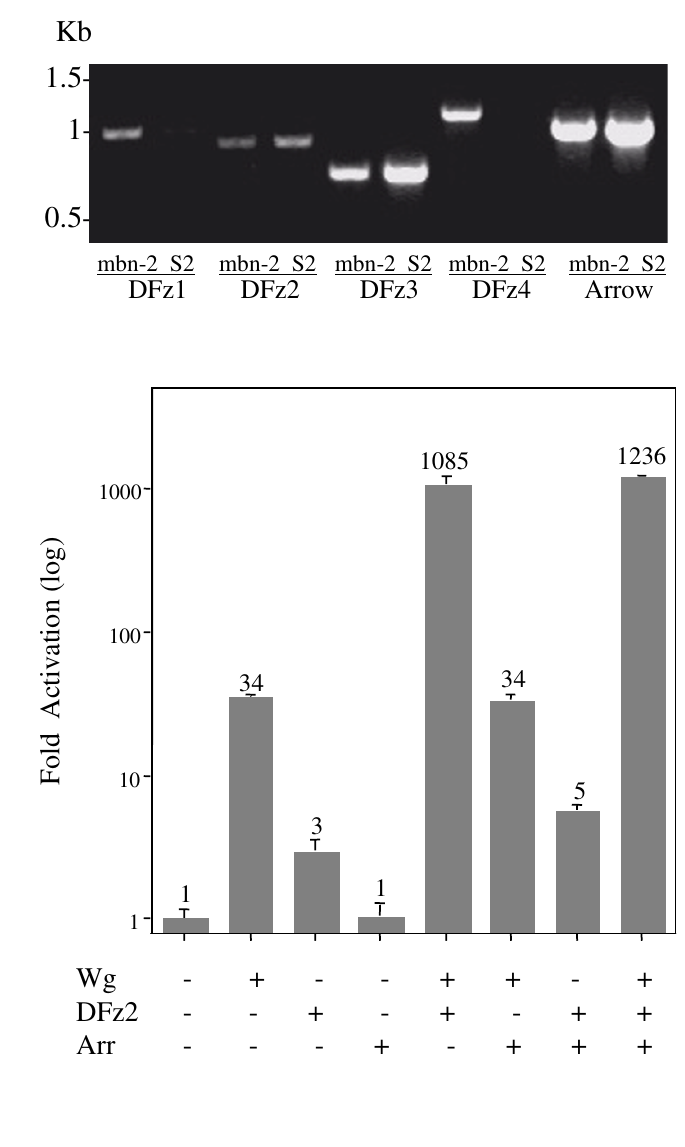
The expression of Wg dual receptors and their activities in S2 cells. One-step RT-PCR was performed to study the expression of Arr and DFz2 in mbn-2 cells and S2 cells (A). 0.1 µ g RNA from each cell line served as the template, and primers for Arr and DFz1, 2, 3 and 4 (see Methods) were used for the RT-PCR reactions. (B) S2 cells were transfected with the indi- cated plasmids and the plasmids as described in Methods. Fold-activation values were measured relative to the levels of luci- ferase activity in cells transfected with empty vectors and normalized by Renilla luciferase activities. These values are plotted as a log function. Averages of the fold-activation are indicated above each column. All experiments were done in triplicate; error bars represent standard